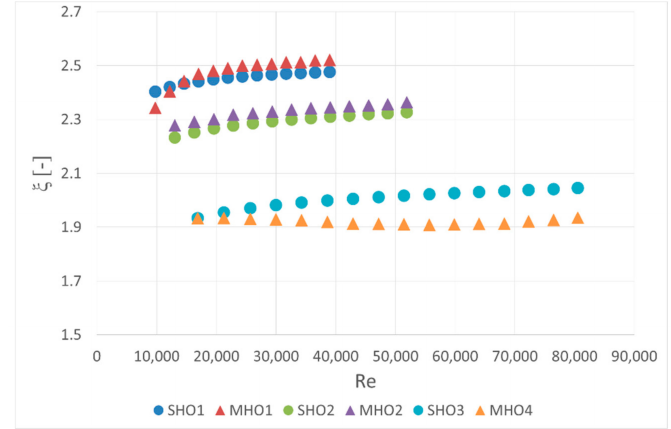
Figure 8. Pressure loss coe ffi cient.